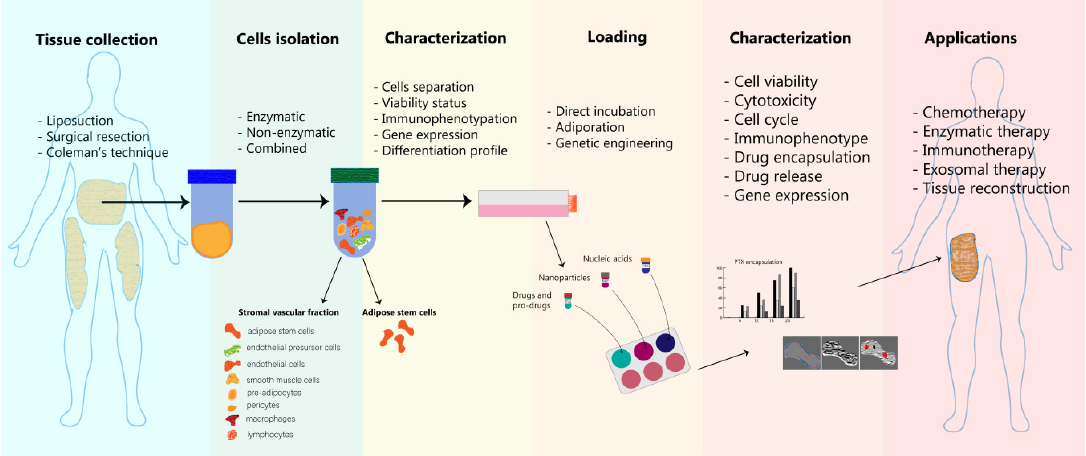
Figure 2. Main adipose tissue processing steps for developing adipocytes-based delivery systems